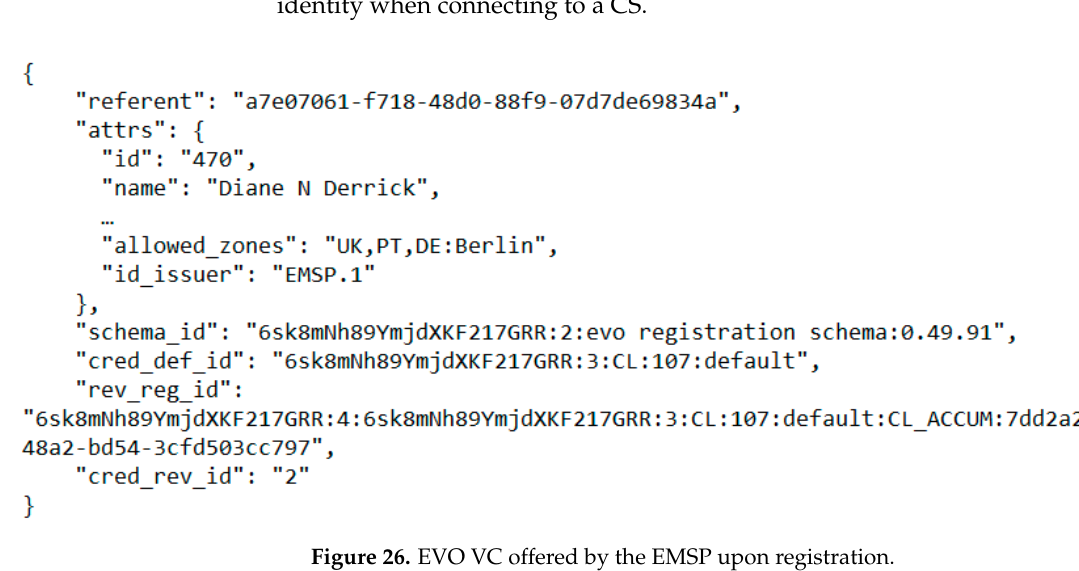
Figure 26. EVO VC offered by the EMSP upon registration.